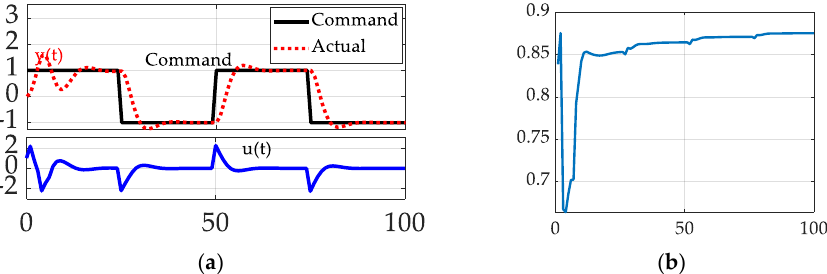
Figure 3. Indirect self-tuner without process zero cancellation (minimum phase plant). ( a ) command and actual output (top); and control (bottom) versus number of timesteps, revealing nominal perfor- mance following the square wave. ( b ) Gain β versus timesteps revealing brief oscillation, and then convergence towards a steady-state